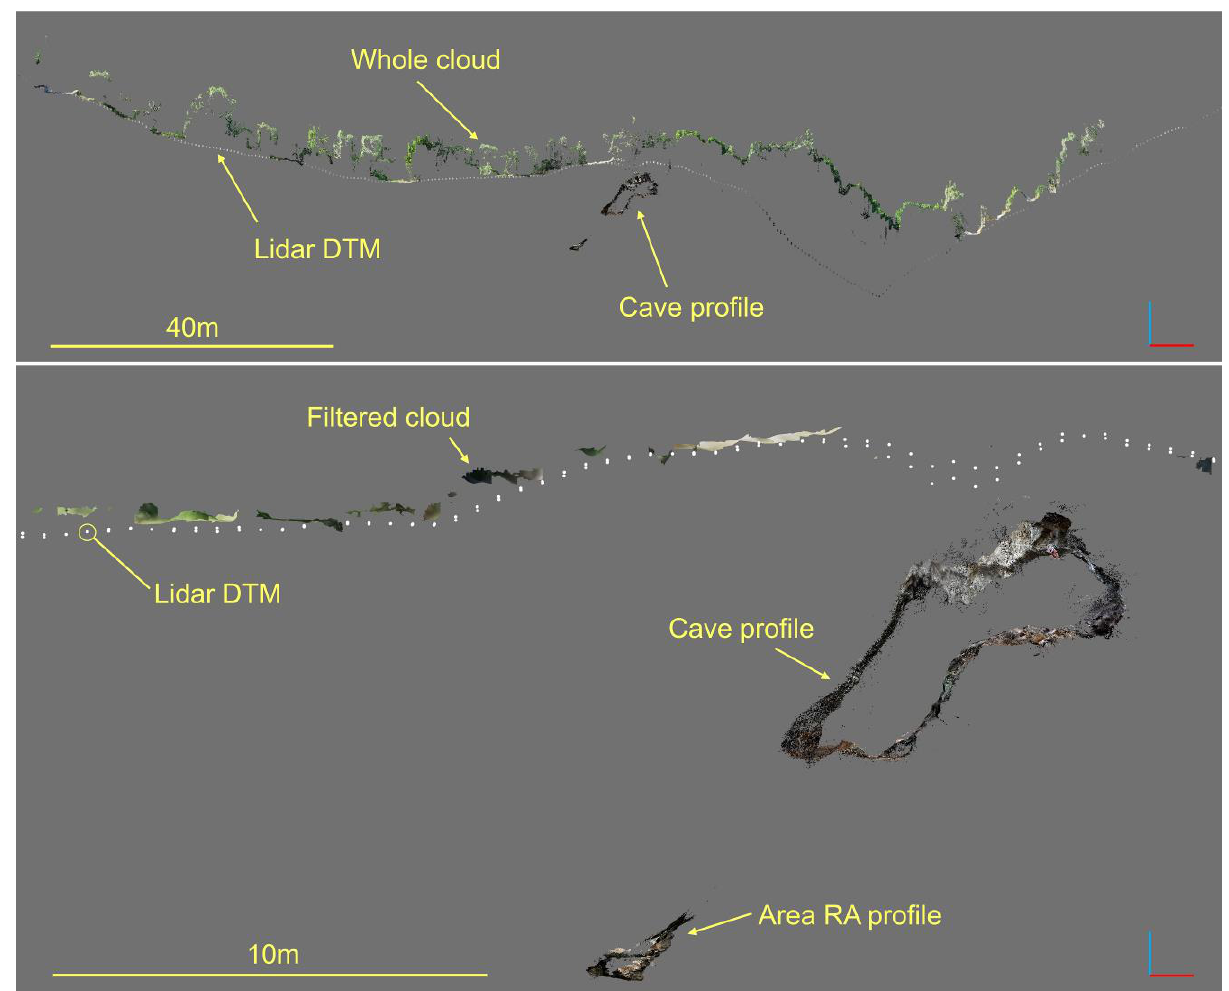
Figure 8 – Slices extracted from the merged 3D model (Lidar, Drone, and cave cloud points) using the slice plane in Figure 7. The DSM cloud point is shown above, below the result of the CANUPO